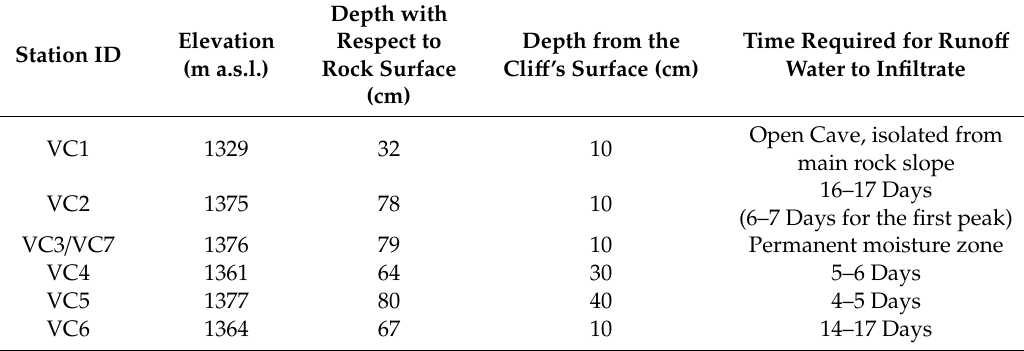
Figure 7. ( a ) Moisture stations, ( b ) VC4 Microclimate observation station data. Table 3. Elevations of monitoring points and depths from rock surface vs rainwater infiltration time intervals.